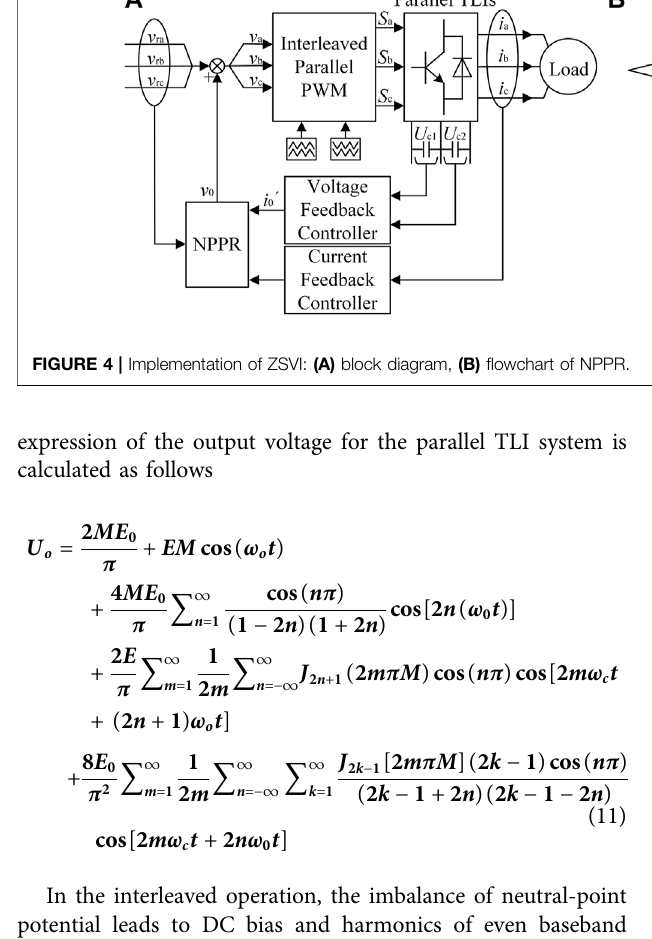
Frontiers in Energy Research |